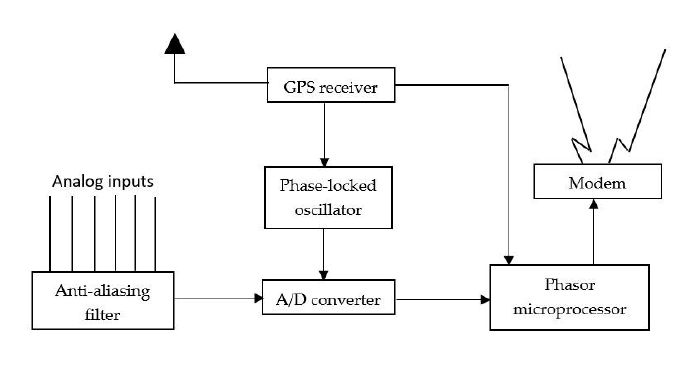
Figure 2. Block diagram of the µ PMU.